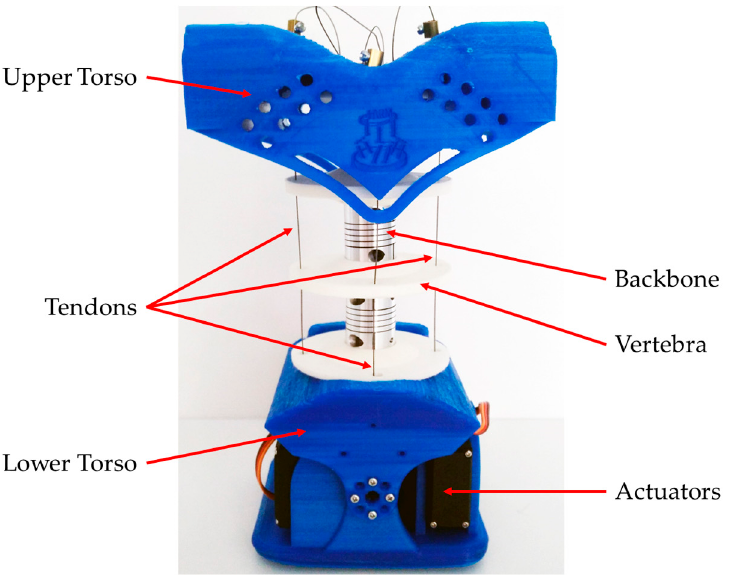
Figure 2. A prototype of the LARMbot’s torso mechanism with its main components